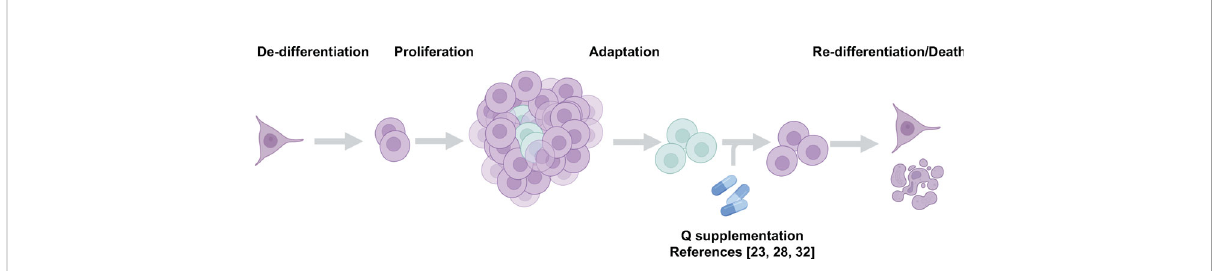
FIGURE 5 Glutamine supplementation reverses the de-differentiated phenotype of cancer cells. Recent studies from our lab suggest glutamine supplementation in melanoma (37, 40) and colorectal cancer (29) is a potential strategy to limit the formation of the dangerous de- differentiated cells found in the tumor core.